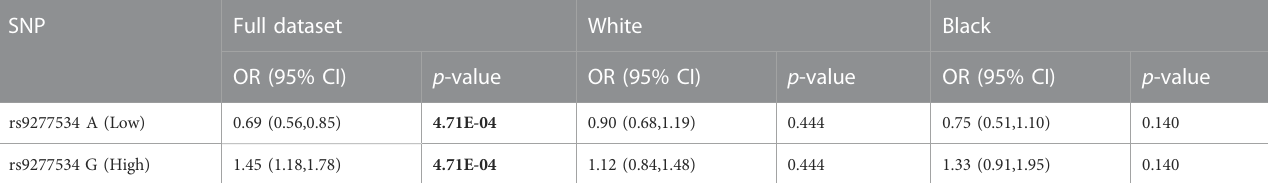
TABLE 6 Logistic regression analysis of DPB1 expression SNP rs9277534. Bold text indicates signi fi cant p